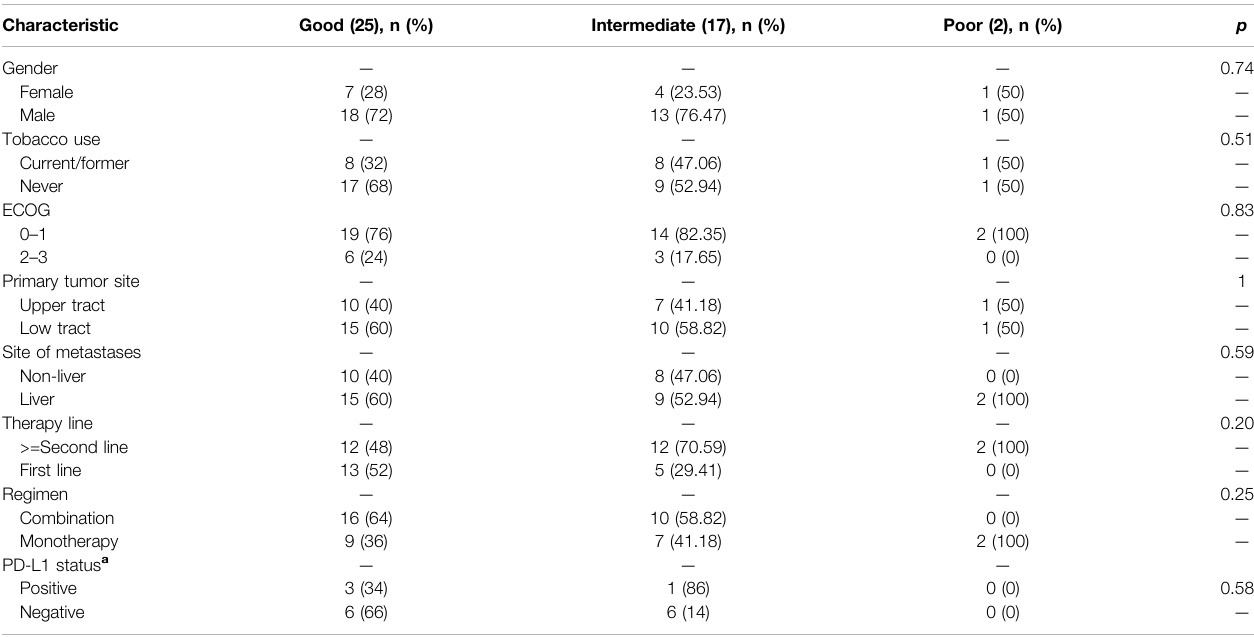
TABLE 3 | Characteristics of patients included in the mUIPI